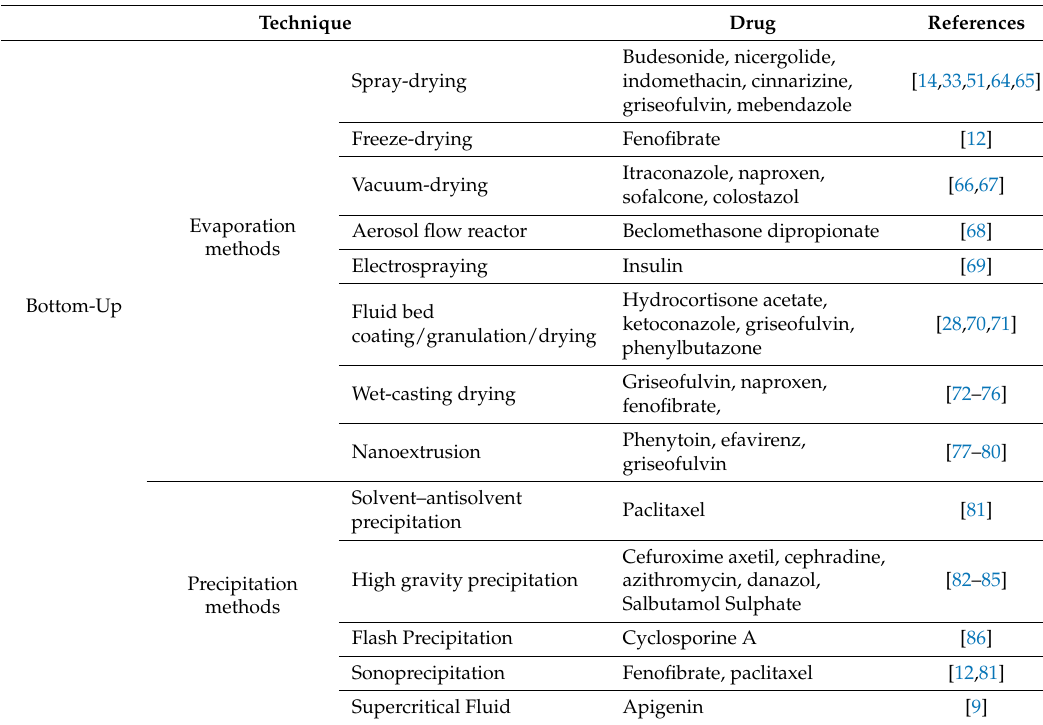
Table 1. Main technologies applied for the production of nanocrystals (nanosuspensions, nanocomposites). References were approximately focused on the last 10